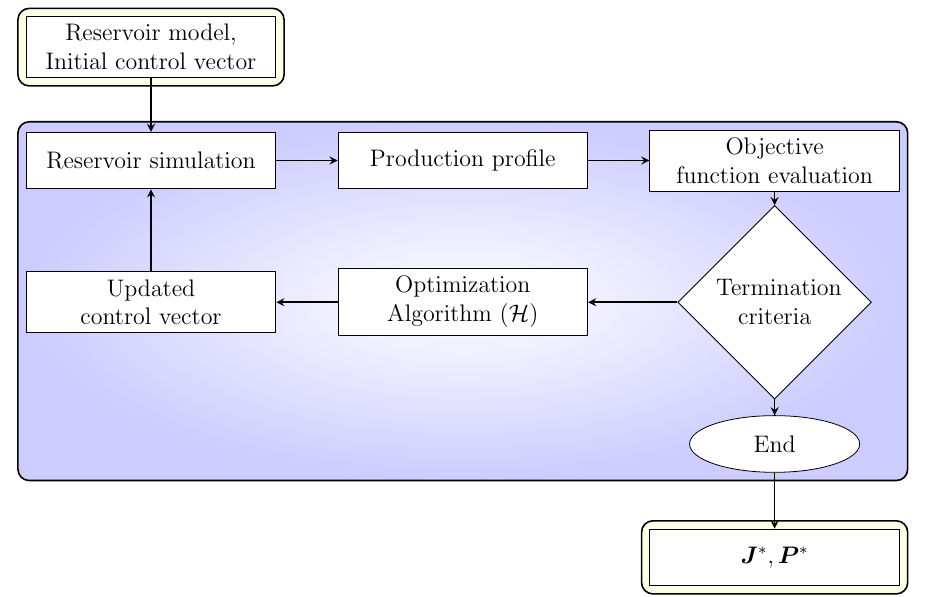
Fig. 12: Multilateral well placement optimization loop Figure 12. Multilateral well placement optimization